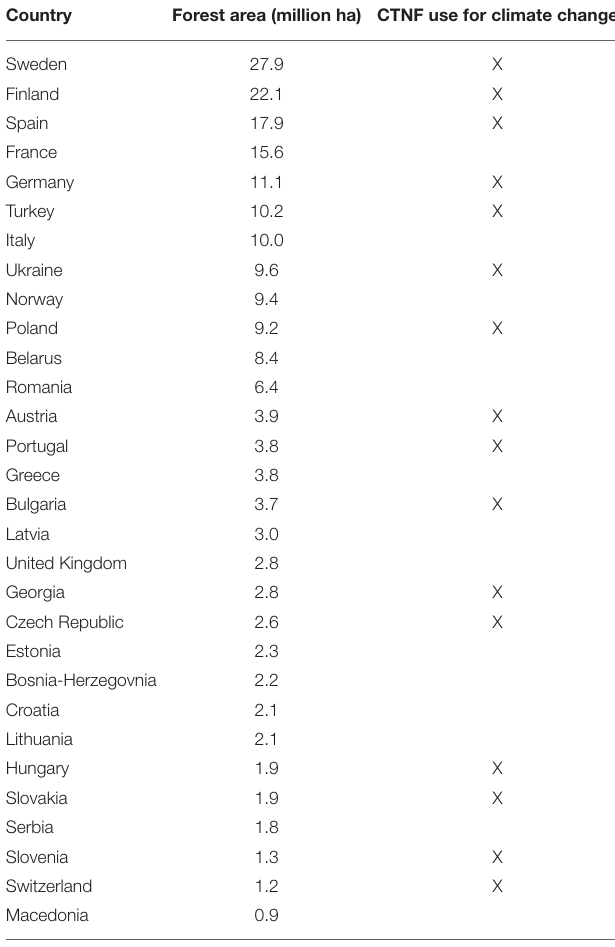
TABLE 1 | The top 30 countries in Europe (excluding the Russian Federation), that account for 98% of European forests with an indication of whether Close-to-Nature Forestry is actively used to mitigate the effects of climate change (source: FOREST EUROPE,